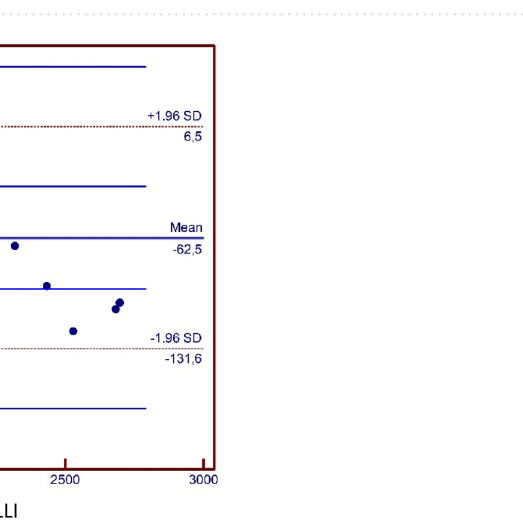
Figure 1. Graph displaying results of T1 relaxation time (in ms) measurement performed with MOLLI and T1-MIX on samples containing albumin (0–200 g/l) dissolved in saline.